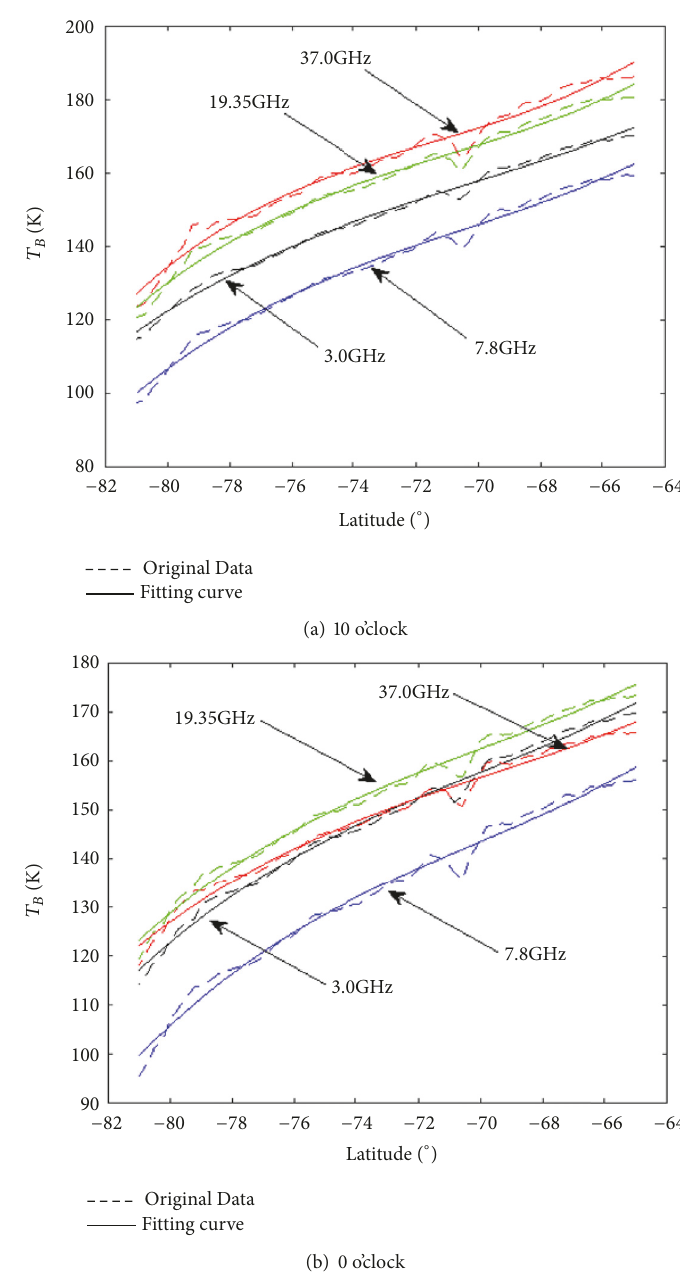
Figure 5: Generation of the standard T